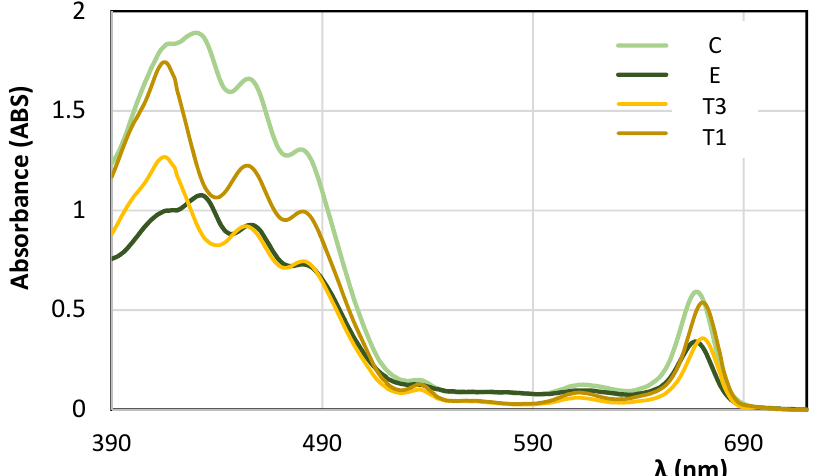
Figure 6. Experimental near UV-vis spectra of fresh EVOOs (samples C and E) and ‘on-the-shelf’ EVOOs (sample T1 and T3). Spectra were recorded after 30 and 38 days from the oil production in the case of sample C and E, respectively. On-the-shelf EVOOs were analyzed after ~4 months from their production. Spectra were recorded with optical path of 0.5 cm.